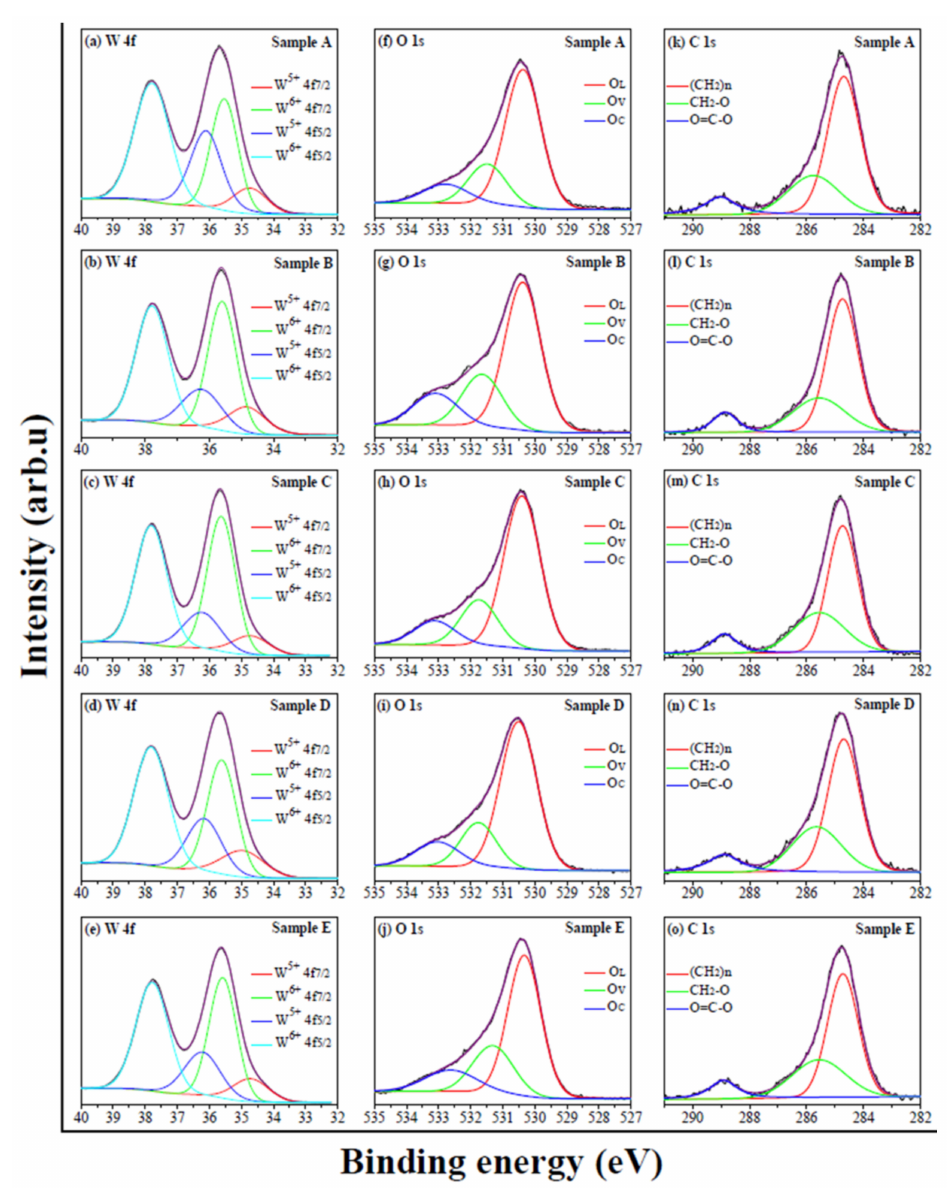
Figure 4. High-resolution W 4f, O 1s and C 1s XPS spectra of as-synthesized WO 3- x aggregates. The deconvoluted peaks indicate the presence of oxygen vacancies and the absorption of carboxylic acid